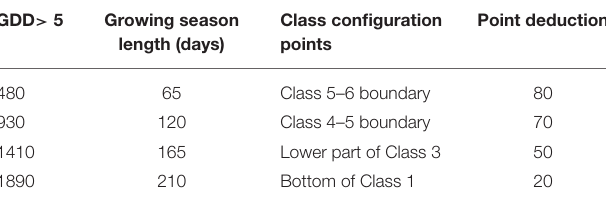
TABLE 6 | Point deductions assigned to GDDs and growing season length for alfalfa. GDD >